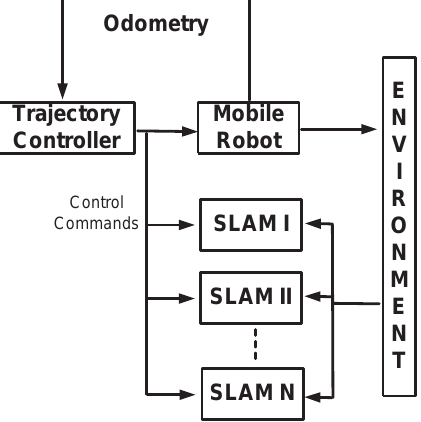
Figure 3. General architecture of the system. The trajectory controller uses the odometry of the mobile robot as input. The SLAM algorithms work independently from each other and from the